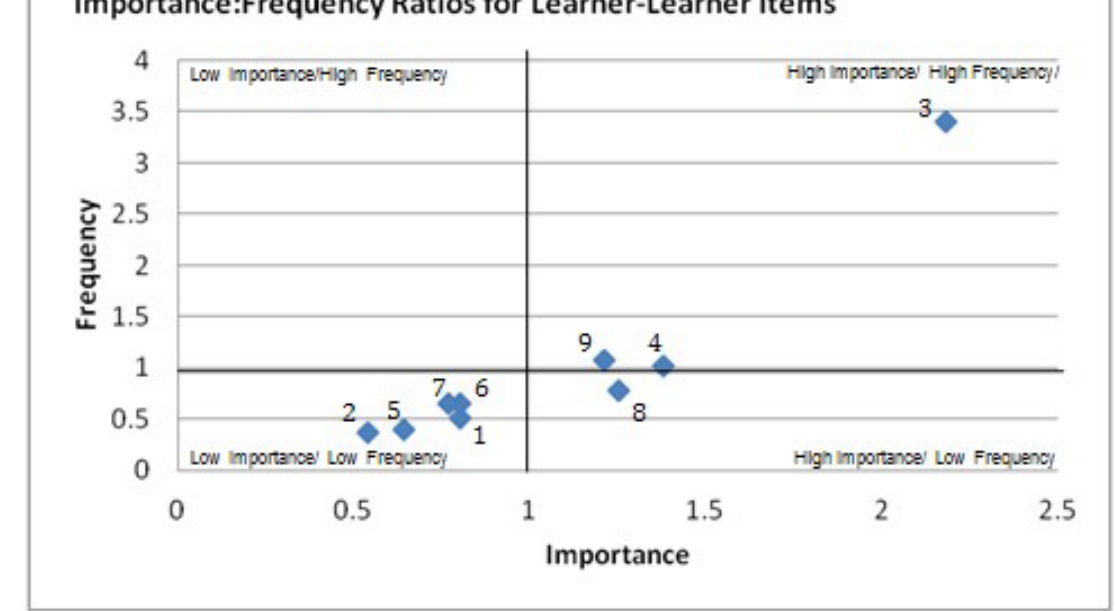
Figure 1 . Importance-to-frequency ratios for learner–learner interaction items. In this matrix analysis, four quadrants of low and high frequency and low and high importance are delineated by horizontal and vertical black lines along the 1.0 value markers. Points are ratios of frequency to importance for each interaction item: (1) introductions, (2) ice- breakers, (3) entire class discussions, (4) small group discussions, (5) social communica- tion, (6) collaborative group projects, (7) peer teaching, (8) exchanging resources, and (9) contributing personal